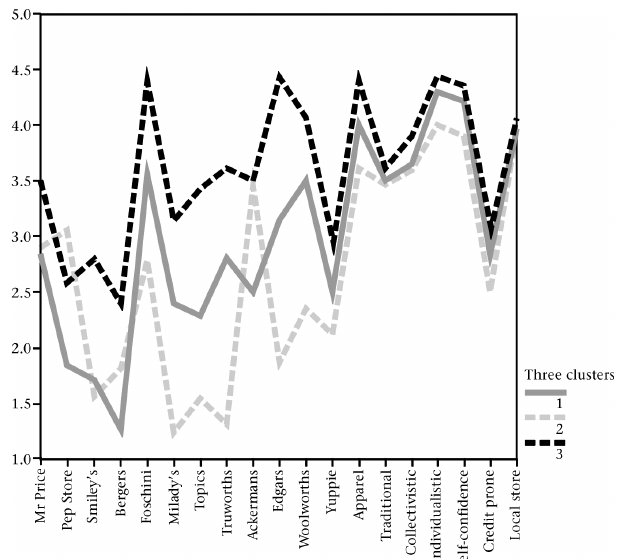
Figure 1: Cluster profiles according to mean scores